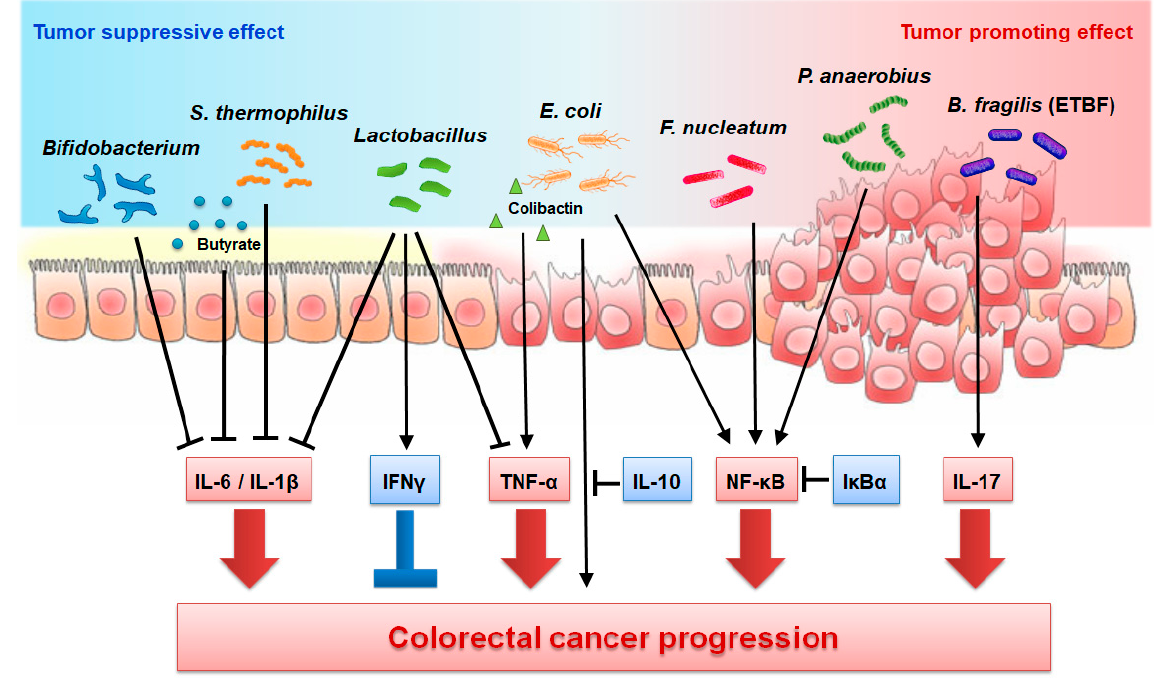
Figure 1. Roles of gut microbiota in regulation of inflammatory mediator production and colorectal cancer (CRC) progression. Some microbiota and their metabolites exert tumor suppressive effects by downregulating tumor promoting mediators such as IL-6, IL-1 β , and TNF- α , and by upregulating the tumor suppressive mediator IFN γ . On the other hand, some microbiota and their metabolite exert tumor promoting effect by upregulating tumor promoting mediators such as TNF- α , NF- κ B, and IL-17. arrow = promote; bar-headed line = inhibit.